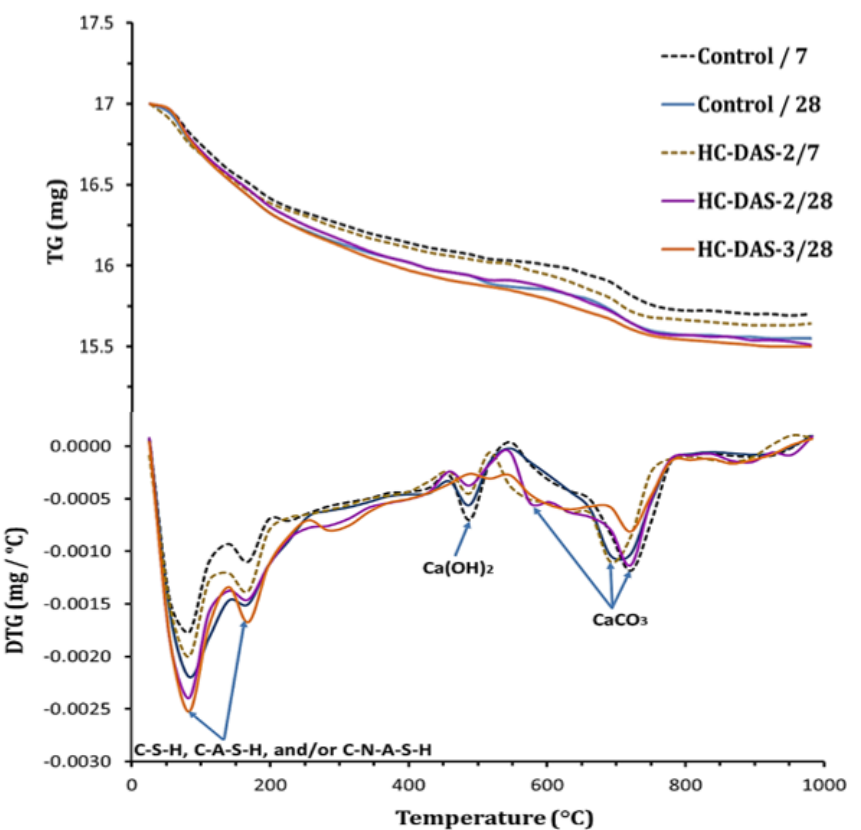
Figure 7. TG/DTG curves of the control sample and HC-DAS-2 pastes at 7 and 28 days as well as the HC-DAS-3 mixture at 28 days of curing.